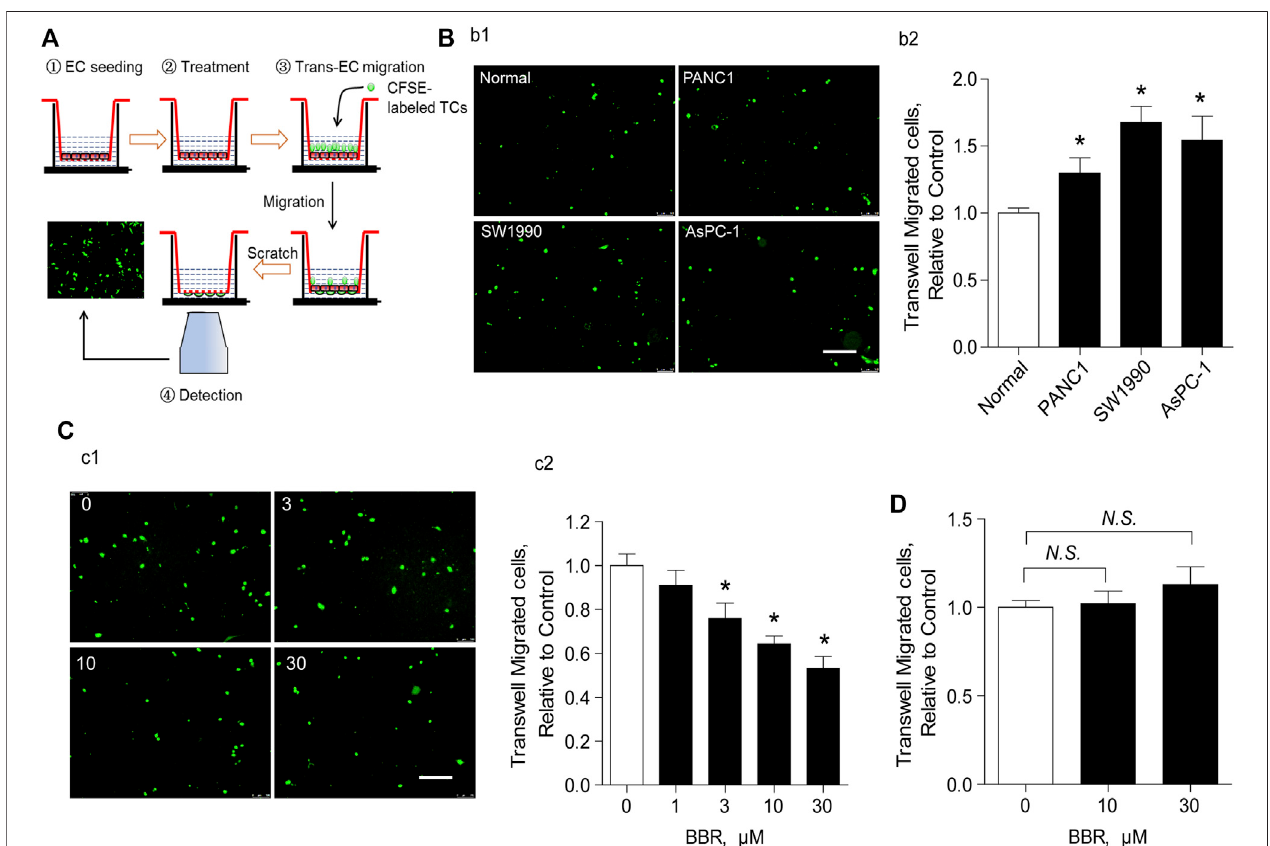
FIGURE 3 | BBR prevents trans-endothelial migration of PC cells in an endothelial-dependent manner (A) . Schematic illustration of trans-endothelial migration of cancer cells analysis (B) . Representative images (b1) and statistical results (b2) of the effect of the EC layer incubation with normal or PC cells (PANC1, SW1990, and AsPC-1) onthetrans-endothelialmigrationofCFSE-labeled AsPC-1 cells. Scalebar =200 μ m (C) .Representative images (c1) and statisticalresults (c2) oftheeffectof BBR treatment on the trans-endothelial migration of CFSE-labeled AsPC-1 cells. Scale bar = 200 μ m (D) . Statistical results of the effect of BBR treatment on the trans-endothelial migration of CFSE-labeled AsPC-1 cells when ECs were absent. * p < 0.05; n = 5 – 10, one-way ANOVA with Dunnett ’ s multiple comparisons test.